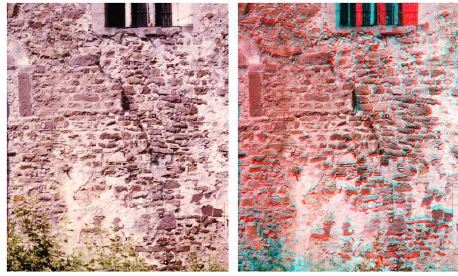
Figure 7. Advanced ground steered civil drone (courtesy Air Force Institute of Technology, Warsaw (Poland)